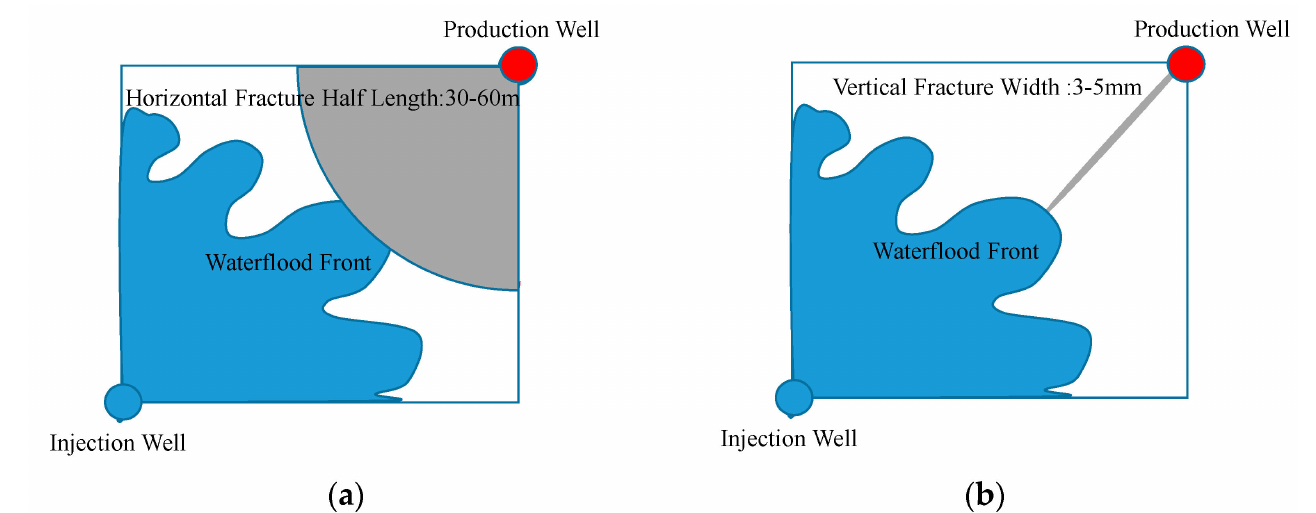
Figure 3. Comparison of water channeling characteristics of horizontal fractures ( a ) and vertical fractures ( b